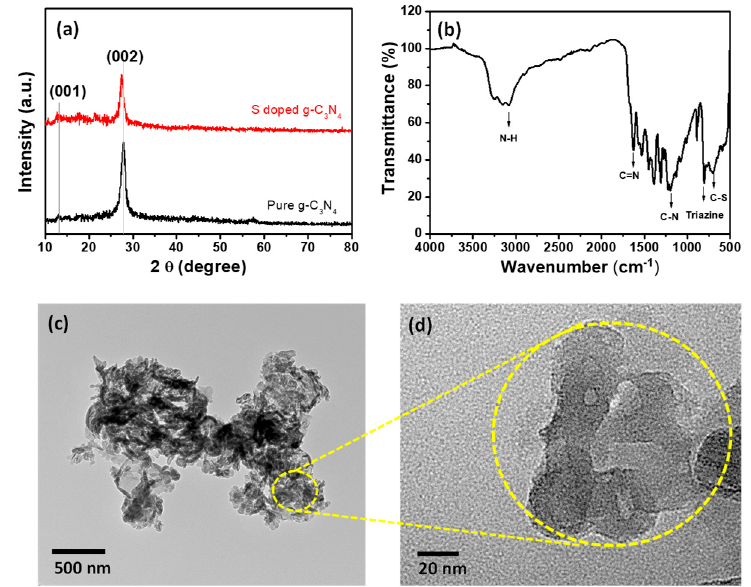
Figure 1. ( a ) XRD patterns of as-prepared samples (pure g-C 3 N 4 , SCNPNS), ( b ) FT-IR spectrum of S-doped g-C 3 N 4 (SCNPNS), TEM images of SCNPNS at the different scale bar of 500 nm ( c ) and 20 nm ( d ).